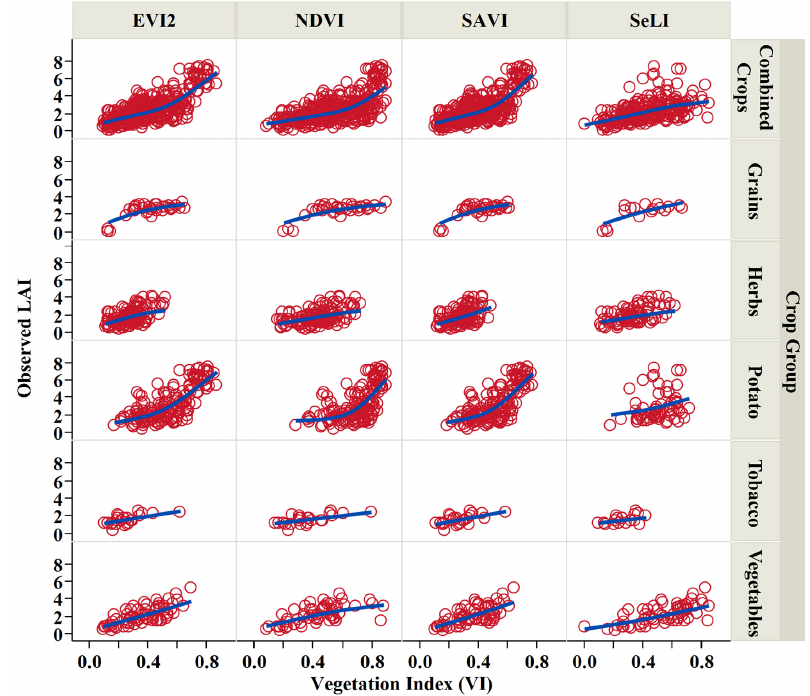
Figure 9 . Measured LAI as a function of vegetation indices (VI) derived from HLS product for the different studied crop groups and all crops combined.